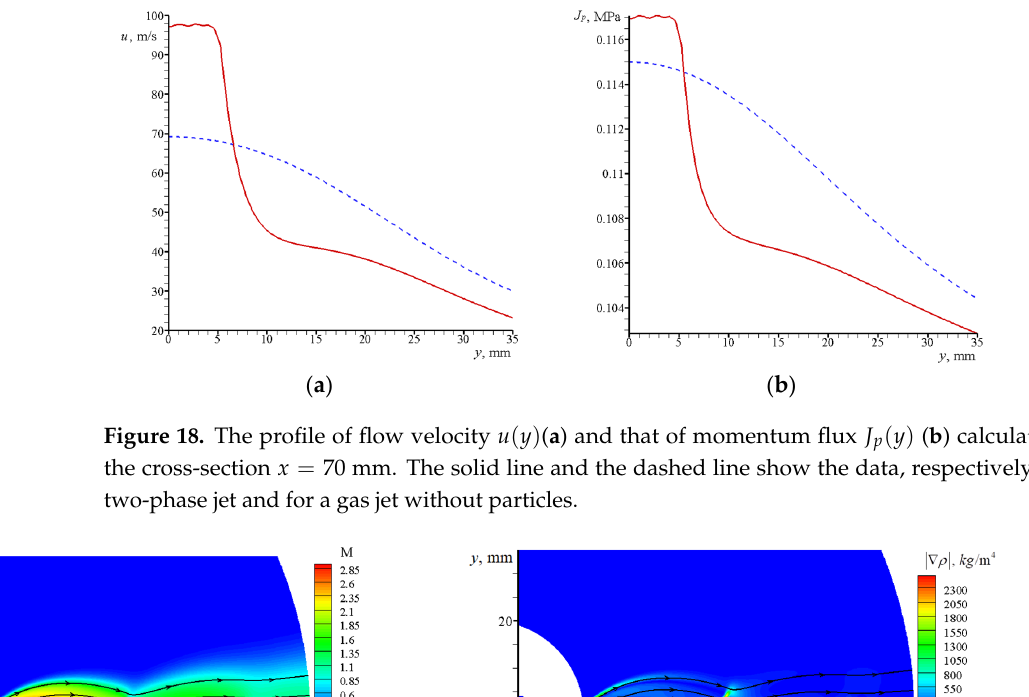
J y ( b ) calculated p